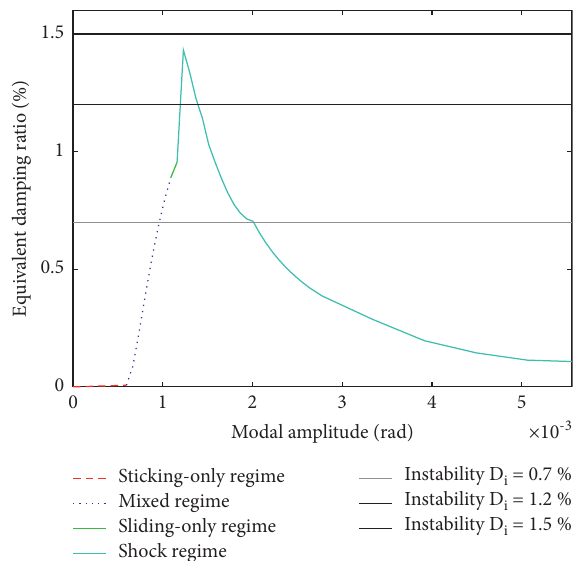
Figure 15: Semi-analytic determined damping diagram for a shock-friction damper with